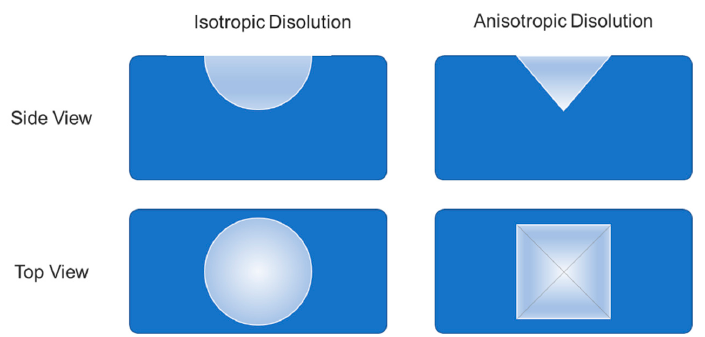
Figure 1. Schematic diagram of isotropic dissolution and anisotropic dissolution. On a β -FeSi 2 crystal, the etch rates of the {111}, {100}, and {001} faces were measured to be 1.57, 1.43, and 1.09 μ m/min, respectively [40]. Planes with the lowest etch rate are more likely to define the shape of etch pits. For example, on a Ge substrate, the (111) plane has more available bonds per unit area than the (110) and (100) planes; hence, the etch rate is slower for the (111) plane [41]. Truncated square- and triangular-shaped etch pits formed on the (100) plane and the (111) plane, respectively, as shown in Figure 2.